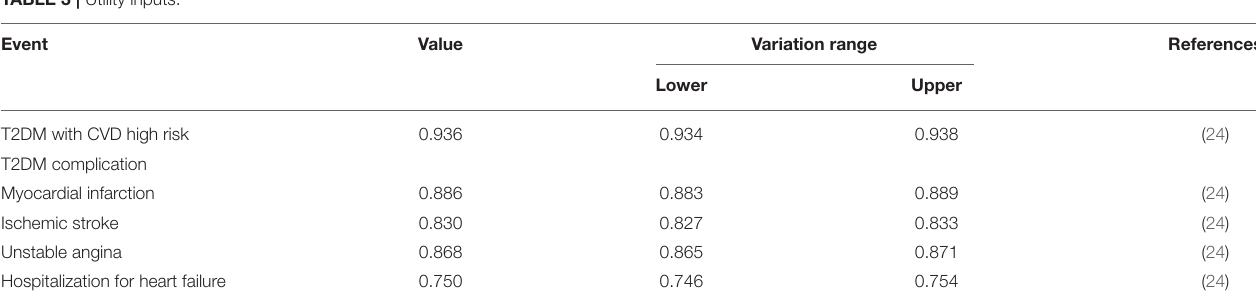
TABLE 3 | Utility